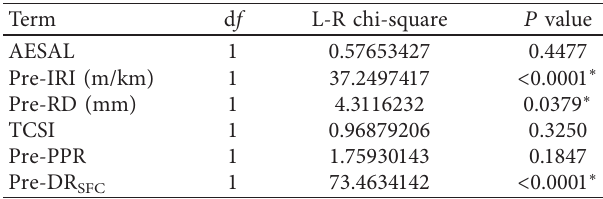
Table 4: Effect likelihood ratio test.